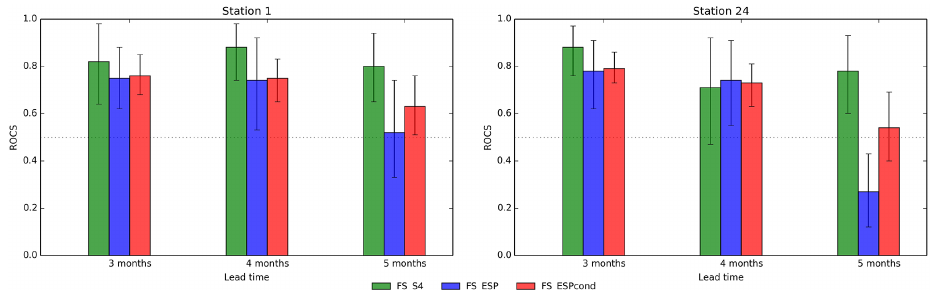
Figure 6. ROCS for the SRI-4 (JFMA) ≤− 0.5 given by FS_S4, FS_ESP, and FS_ESPcond for different lead times, for two of the stations (1, 24). The error bars represent the 5–95th percentiles of the bootstrapped ROCS values.